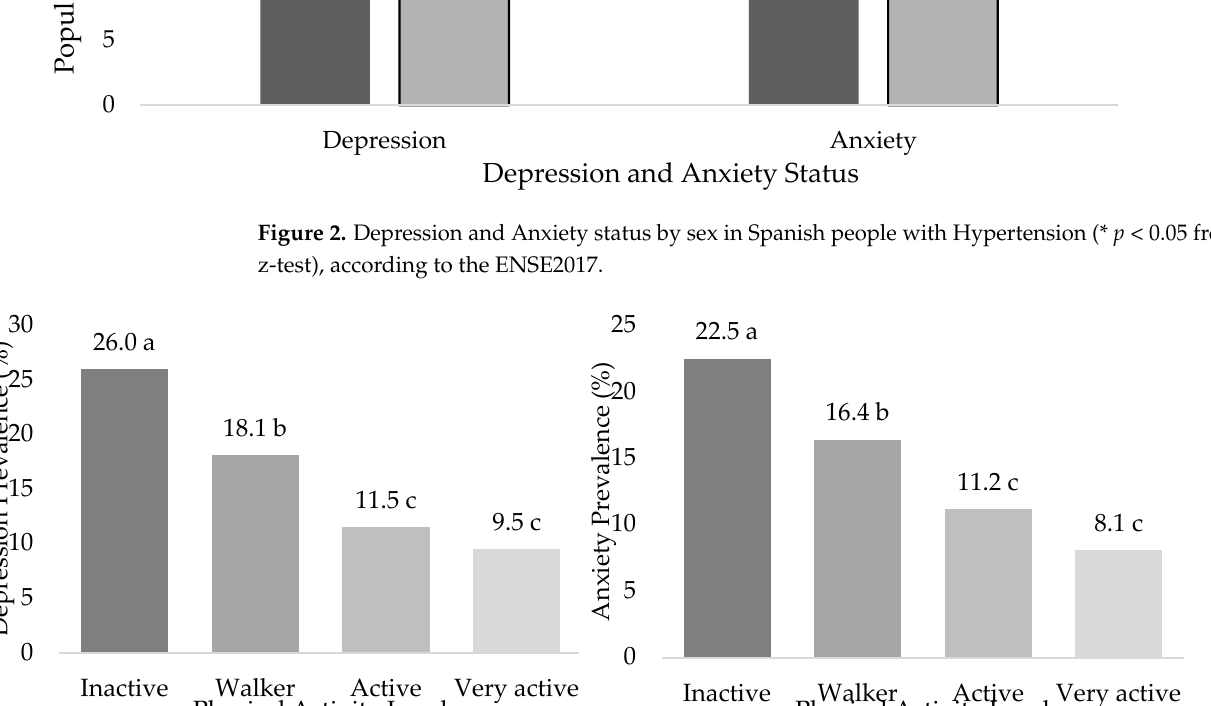
Figure 2. Depression and Anxiety status by sex in Spanish people with Hypertension (* p < 0.05 from z-test), according to the ENSE2017.